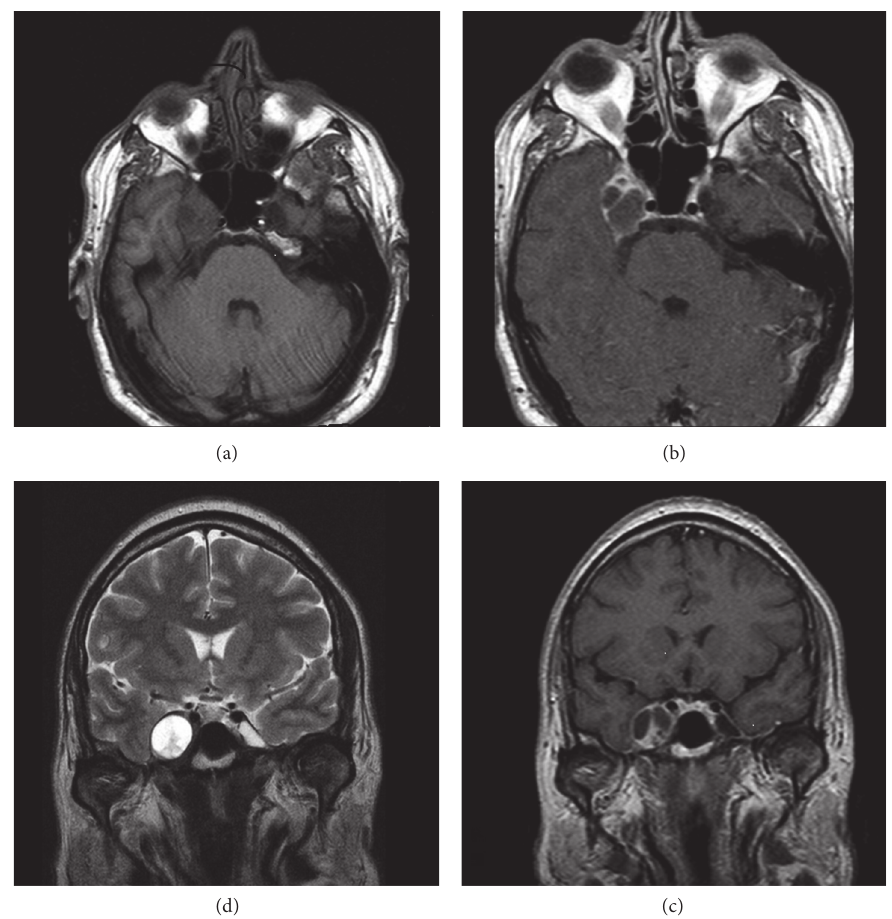
Figure 1: One can see clockwise the MR images of the tumour on T1-weighted, on T1 with contrast, and on T2-weighted